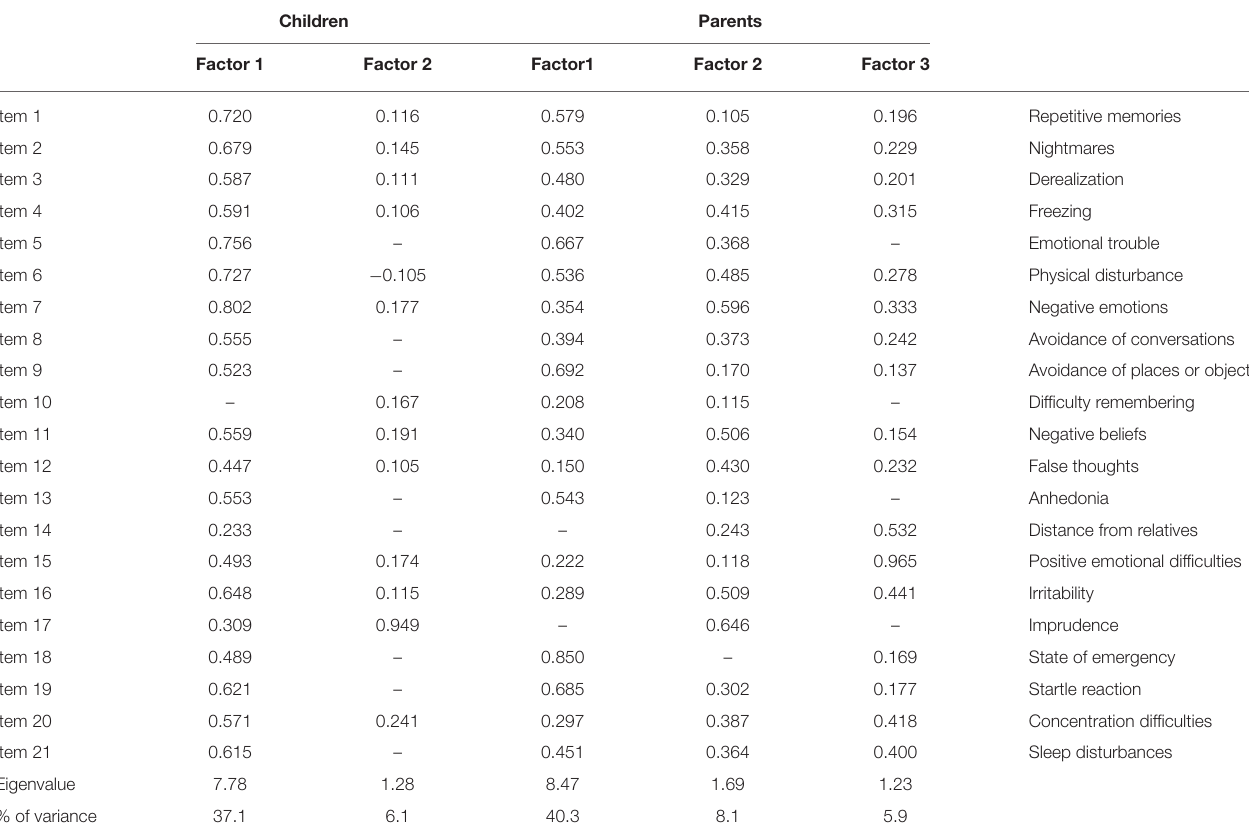
TABLE 1 | PCA for children and parents. Matrix of